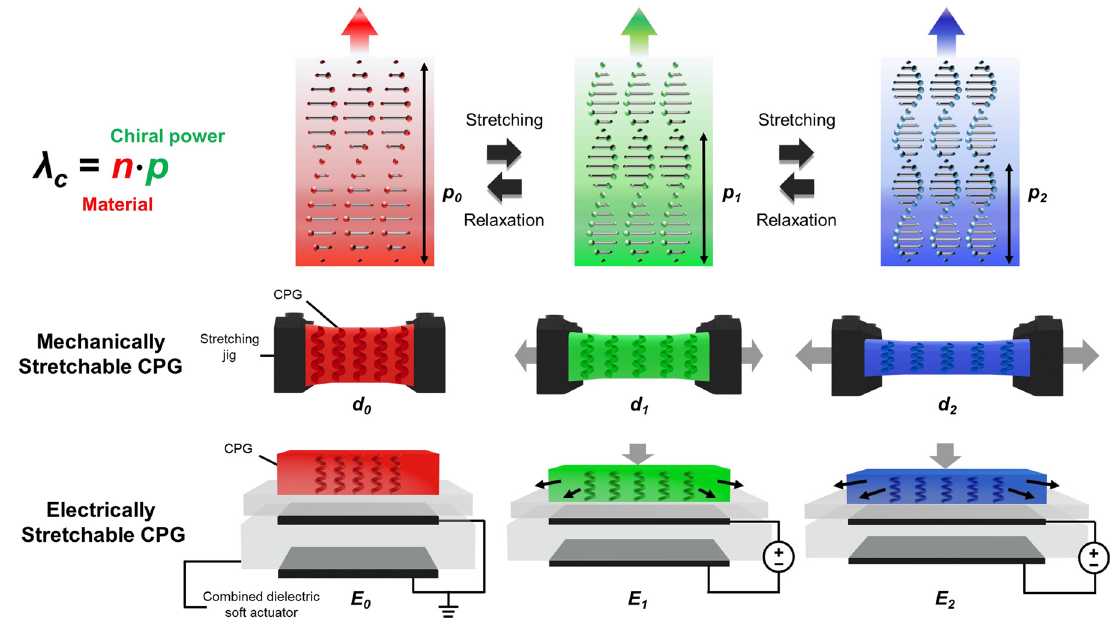
Figure 1: A schematic showing the photonic stopband wavelength-tuning mechanisms of electrically stretchable